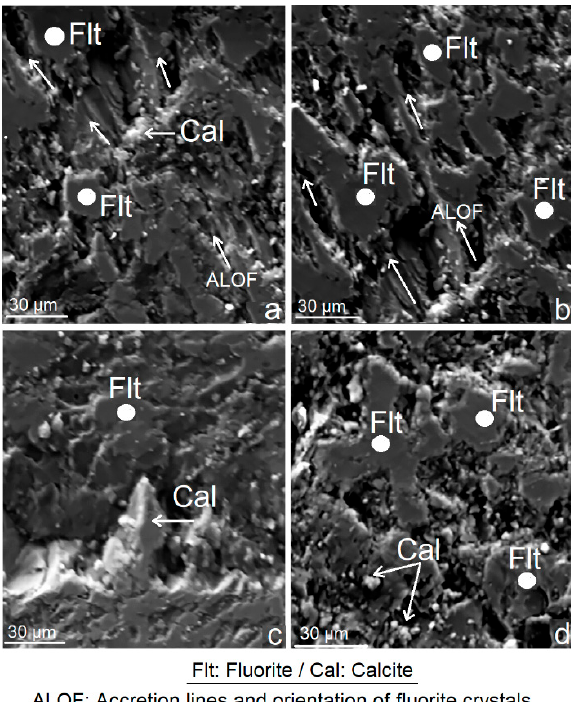
Figure 2. Microphotographs ( a – d ) of the natural fluorite (NF) sample investigated, showing typical banding.